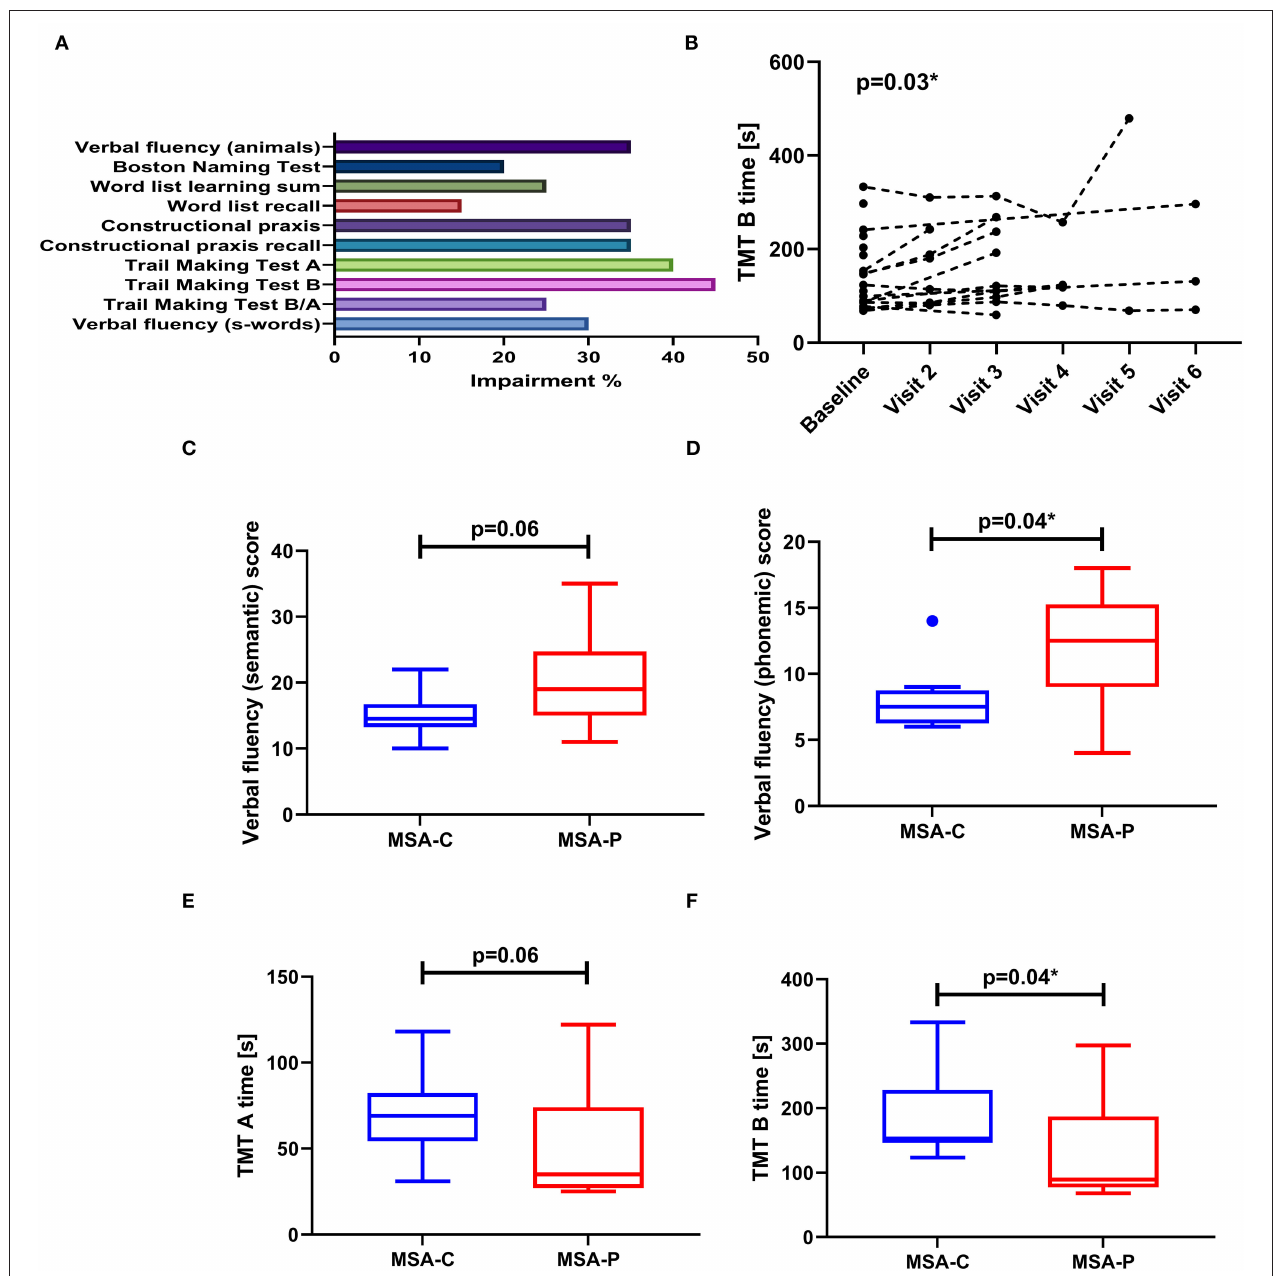
FIGURE 1 | (A) Bar graph showing the proportion of impairment (z-score < − 1.28) considering the CERAD battery plus subitems at baseline examination (MSA n = 20). (B) Line plot demonstrating significant worsening of the Trail Making Test B (TMT-B) subitem over time ( p = 0.03*), reflected by an increase in time needed to complete this task. (C–F) Comparison of MSA-C and MSA-P motor subtypes regarding baseline cognitive function. Data are presented as boxplot (with median, IQR and outlier according to Tukey’s